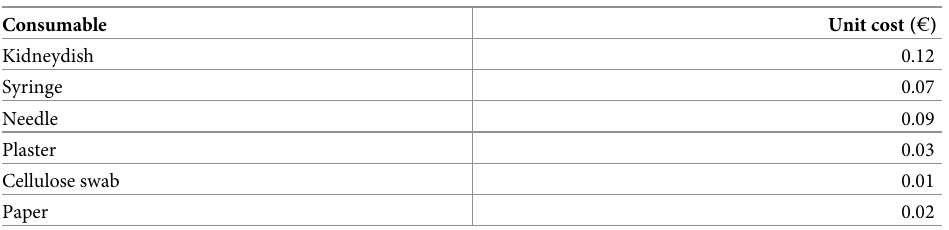
Table 2. Costs of consumables including taxes from